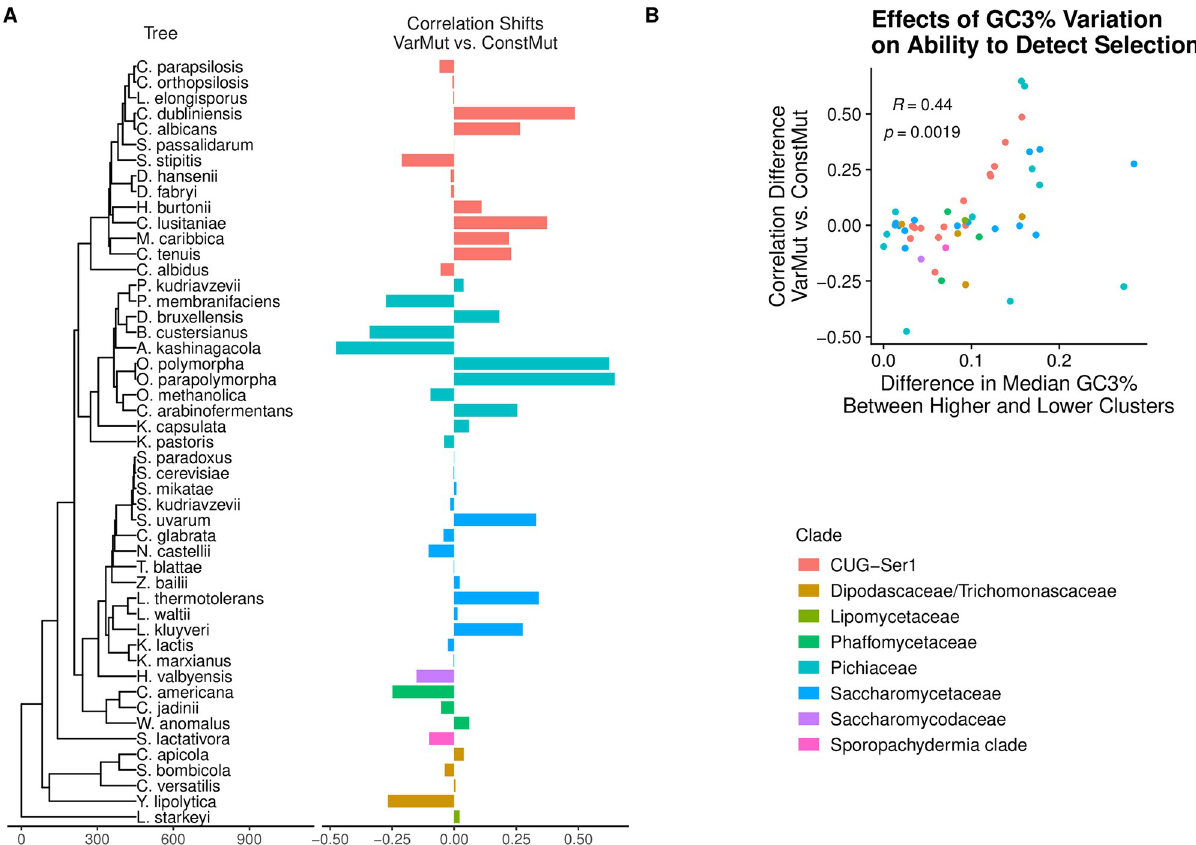
Fig 5. Impact of intragenomic variation in non-adaptive nucleotide biases on predicting gene expression across 49 Saccharomycotina yeasts. Clade names are taken from [18]. (A) Change in Spearman correlation between empirical and predicted gene expression when fitting VarMut model relative to ConstMut model. A positive value indicates an improvement in correlation when fitting the VarMut model. (B) Relationship between the shift in correlations as a function of the difference in median GC3% content between the Lower and Higher GC3% clusters.